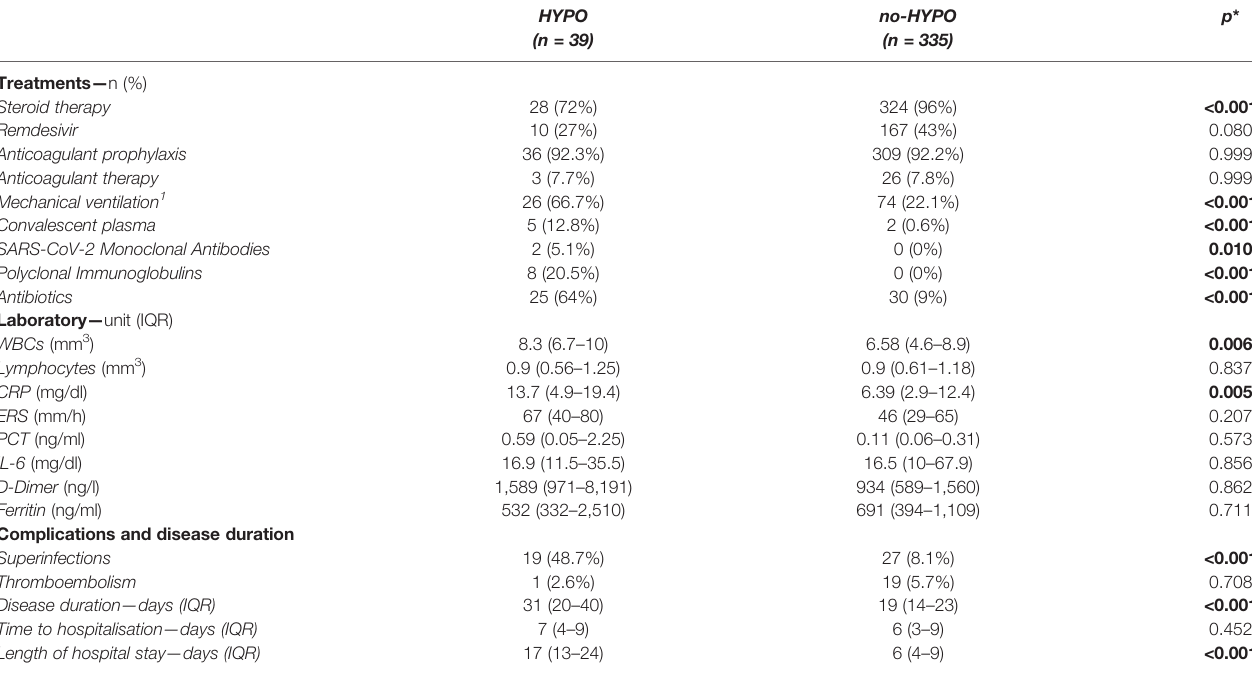
TABLE 2 | Treatments, laboratory parameters, clinical complications and disease duration between HYPO vs. no-HYPO in our COVID-19 cohort.